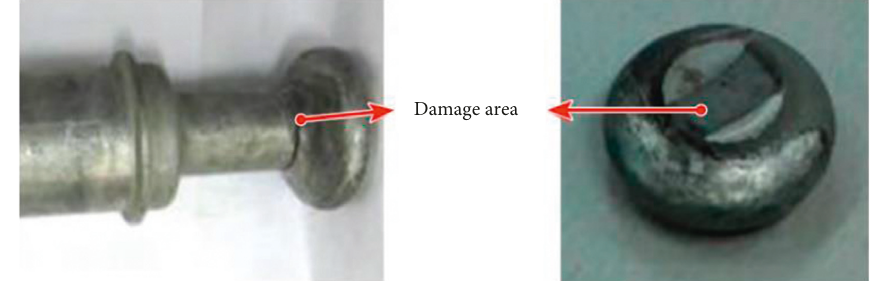
Figure 38: Failure mode of ball-joint at the lower end of insulator string.